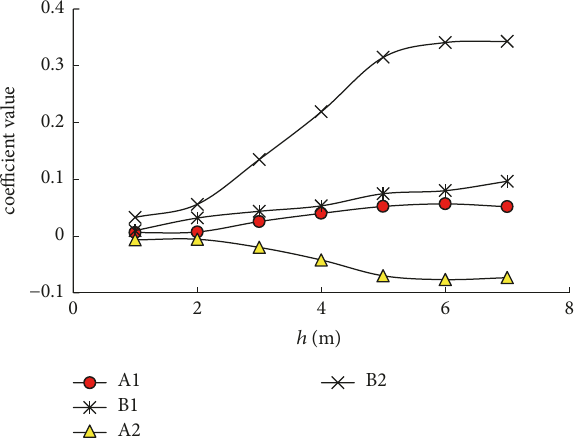
Figure 17: Relationship between filling height and 𝐴 𝑖 , 𝐵 𝑖 .